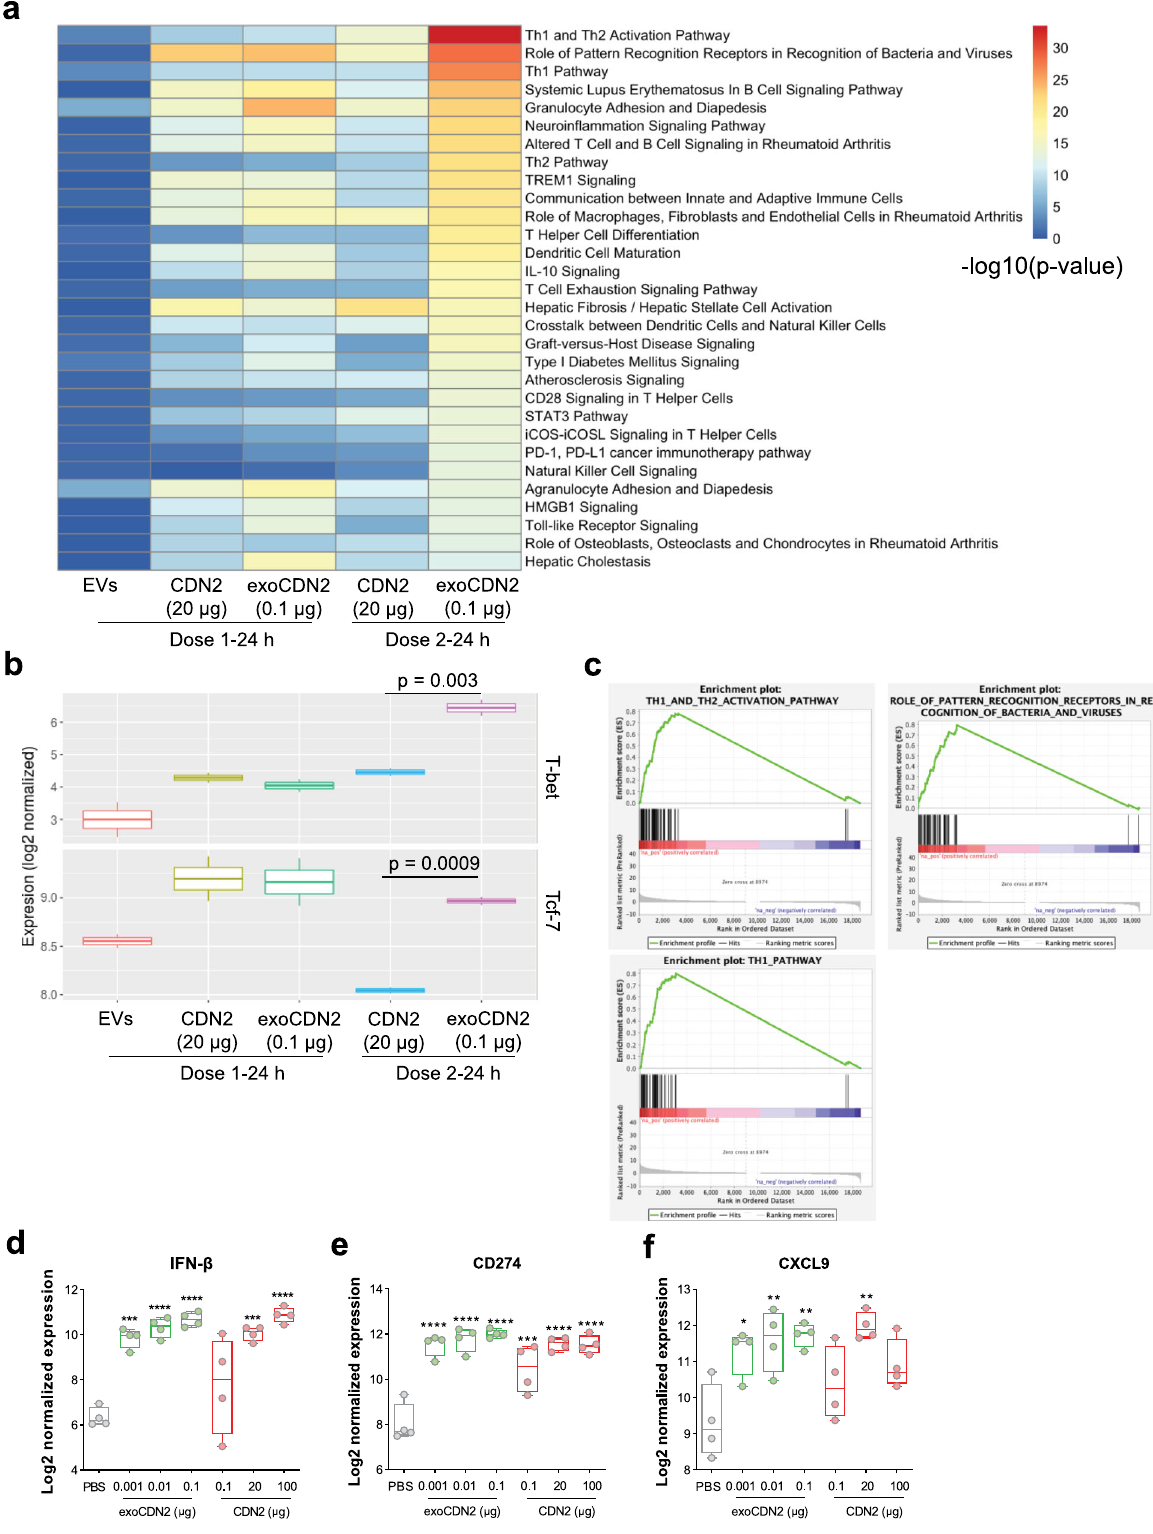
Using Nanostring analysis, we further evaluated the expression of immune related genes in the TME that are immediately altered (4 h) after IT injection with increasing doses of exoSTING (0.001, immediate target gene for STING pathway activation, IFN- β , is induced in a dose-dependent manner by both exoSTING and